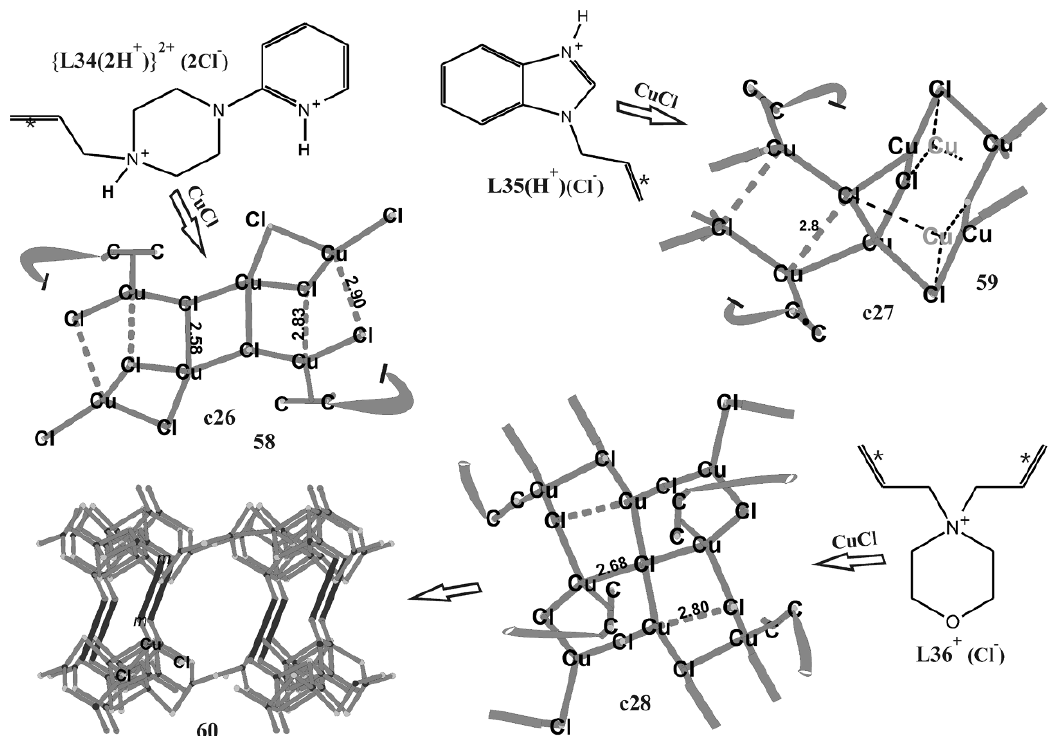
Figure 13. Structural genesis of C26-C28 fragments in 58-60